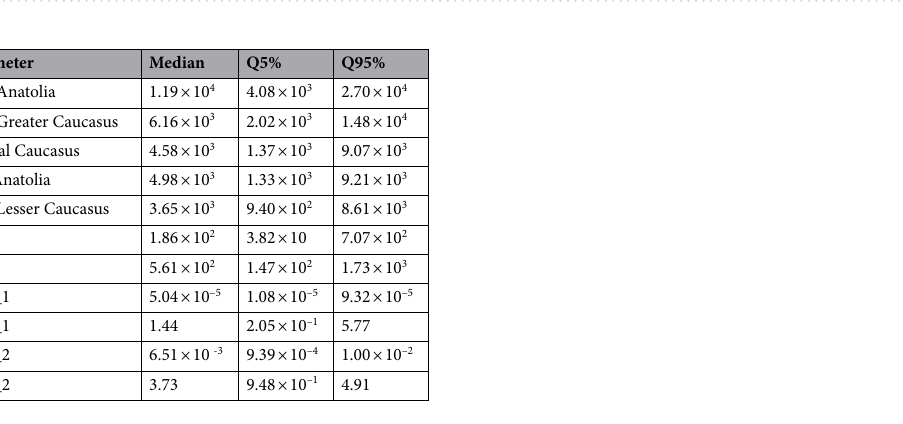
Table 2. Parameter estimates for the best demographic scenario (Scenario 2) indicated by DIYABC based on ABC method using nuclear microsatellites.